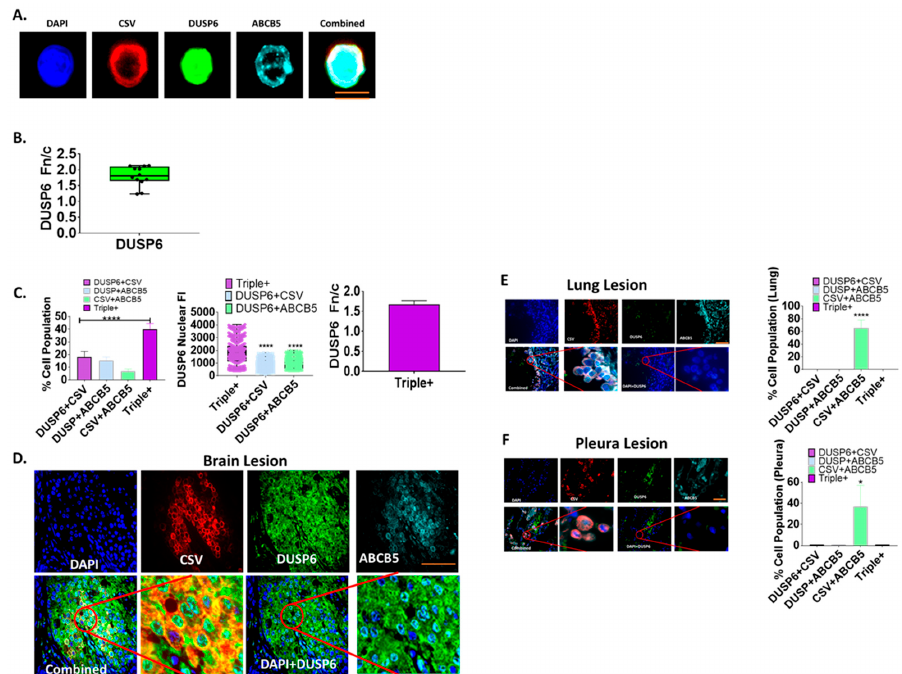
Figure 2. Nuclear-biased dual-specificity phosphatase 6 (DUSP6) in CTCs and brain metastases from metastatic TNBC patients. ( A ) Nuclear DUSP6 presented in CTCs from metastatic breast cancer patients. CTCs were labelled with anti-human DUSP6, cell surface vimentin (CSV), ABCB5, and DAPI for microscopy. ( B ) The nuclear bias of DUSP6 in CTCs from stage IV metastatic breast cancer patients ( n = 5 patients). Nuclear/cytoplasmic intensity of DUSP6 was measured by microscopy. ( C ) DUSP6 expression in breast cancer metastases to the brain. Fluorescence labelling of DUSP6, CSV, and ABCB5 was performed for ASI microscopy analysis. Bar graph represents cells double-positive for either DUSP6/ABCB5/CSV or triple-positive for all three markers. The second bar graph displays the nuclear fluorescence intensity in double- or triple-positive cells for DUSP6. >500 cells counted per patient. Representative image of nuclear DUSP6 expression in ( D ) brain metastasis tissue ( n = 21 patients). ( E ) DUSP6 expression in breast cancer metastases to the lung and ( F ) pleura ( n = 5 patients) from metastatic TNBC patients. Bar graph represents cells double-positive for either DUSP6/ABCB5/CSV or triple-positive for all three markers. Scale bars = 10 µm and are shown in orange . Data represent mean ± SE. Unpaired t -test. * p < 0.05, **** p < 0.0001 denote significant differences.